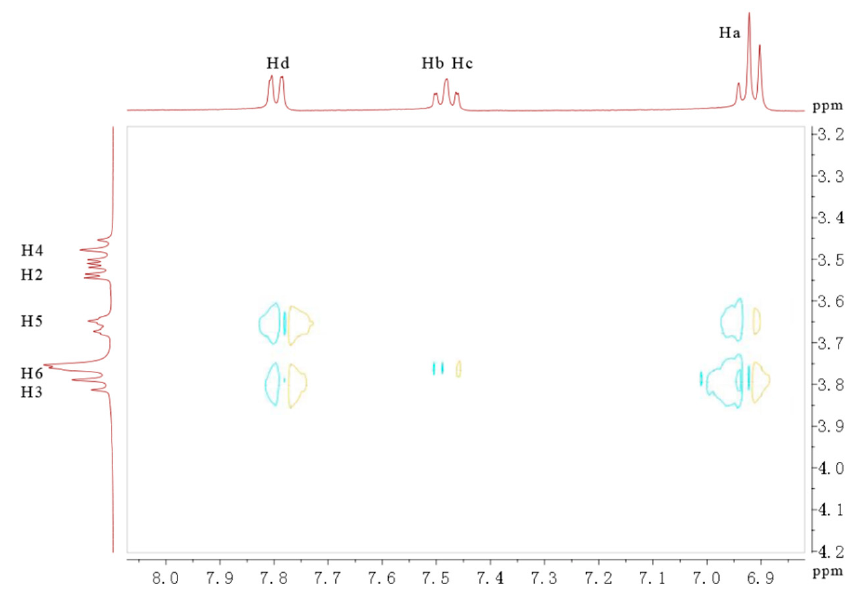
Figure 6. Part of the 2D ROESY spectrum of SA/ β -CD in D 2 O.